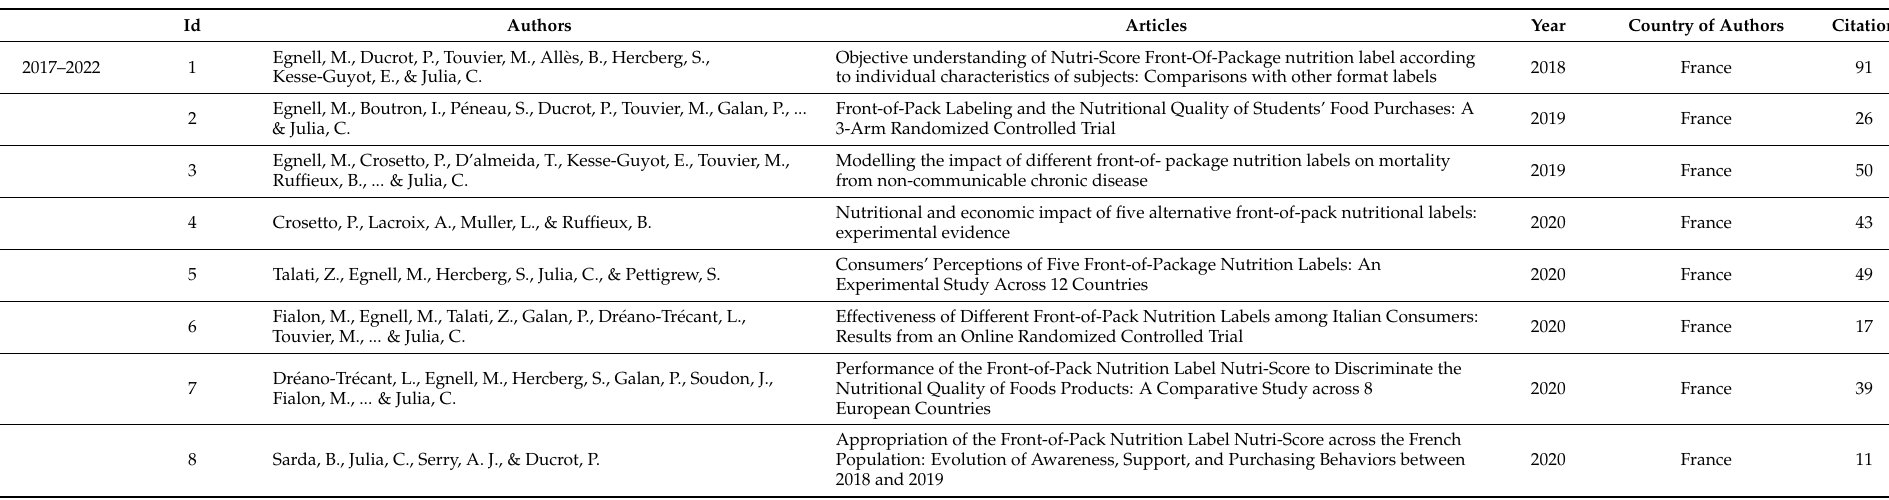
Table 18. Evolution of Composition of co-citation network 3 in terms of authors, articles, year, country of authors and citation.